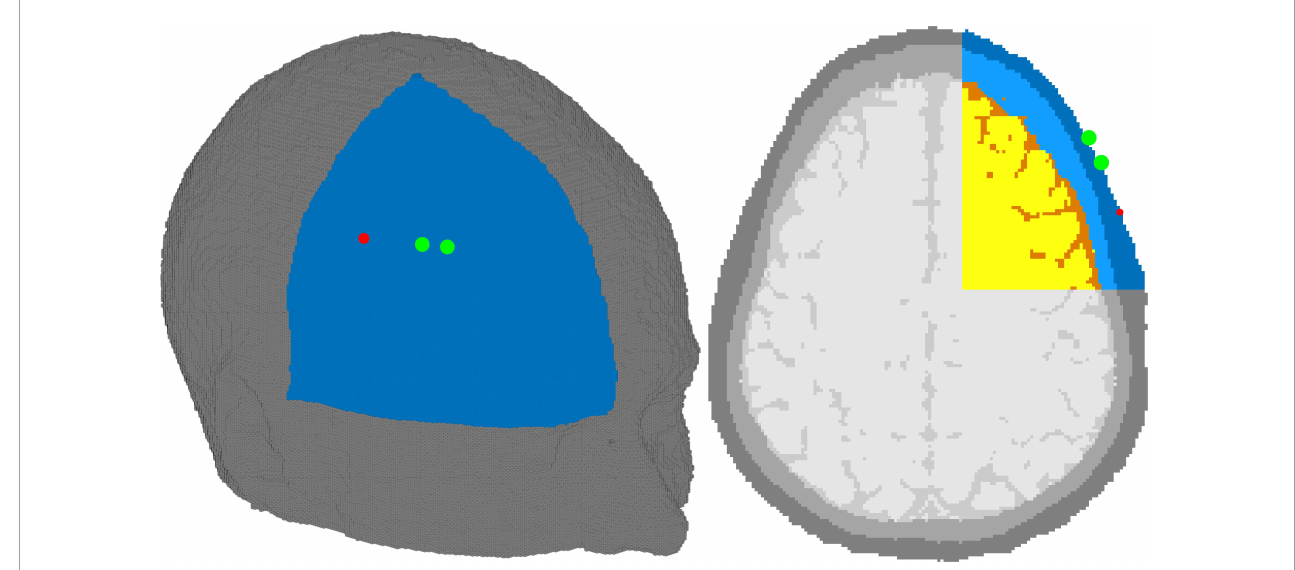
FIGURE3 Adult head model with source (red dot) and detectors (green dot). The source-detector distances were 2 and 3 cm. The tissues shown are skin (dark blue), skull (light blue), cerebrospinal fluid (orange), and brain (yellow). Due to GPU limitations, only the right upper octant of the head was simulated and is shown above–gray tissues not included in the